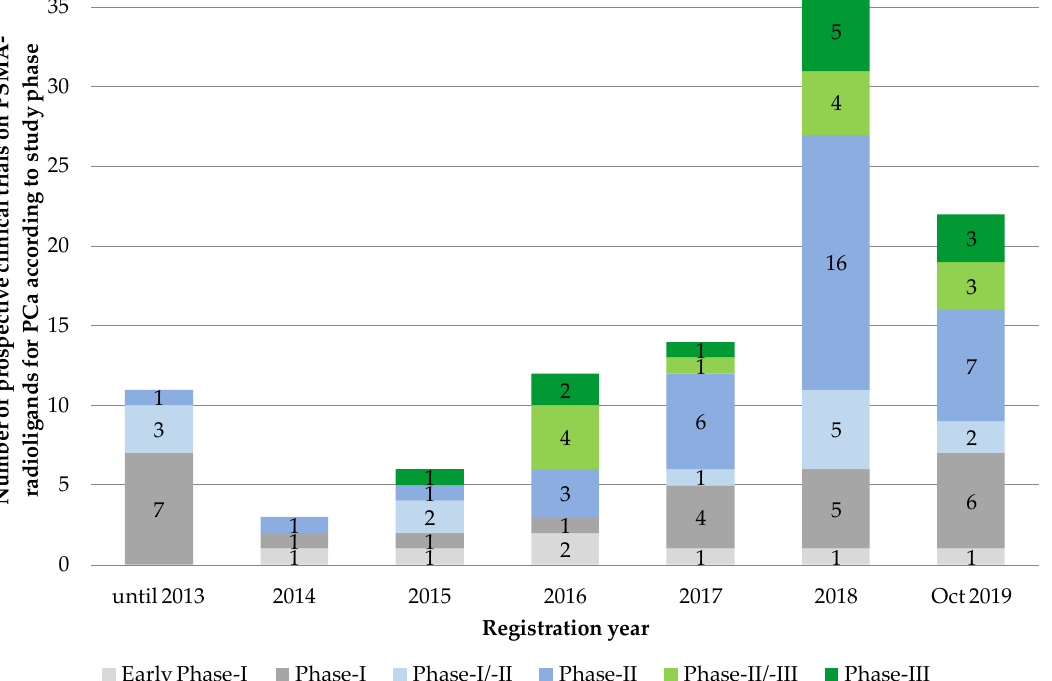
Figure 3. Number of prospective clinical trials on PSMA-radioligands for prostate cancer according to registration date and study phase ( n = 104). Source: Own figure based on the evaluation of the ClincalTrials.gov dataset [30]. Table 1. Applied radiotracers and organizational parameters of the included prospective clinical prostate cancer-related trials with PSMA-radioligands from the ClinicalTrials.gov registry ( n =